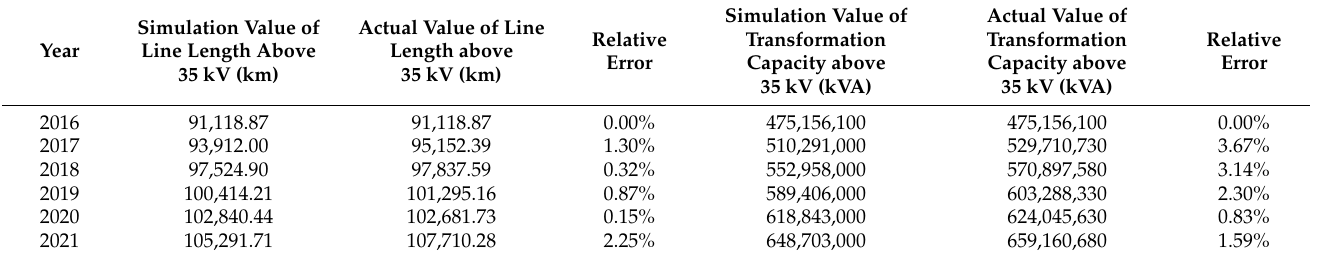
Table 4. Comparison between simulation value and actual value of key indicators of social investment.